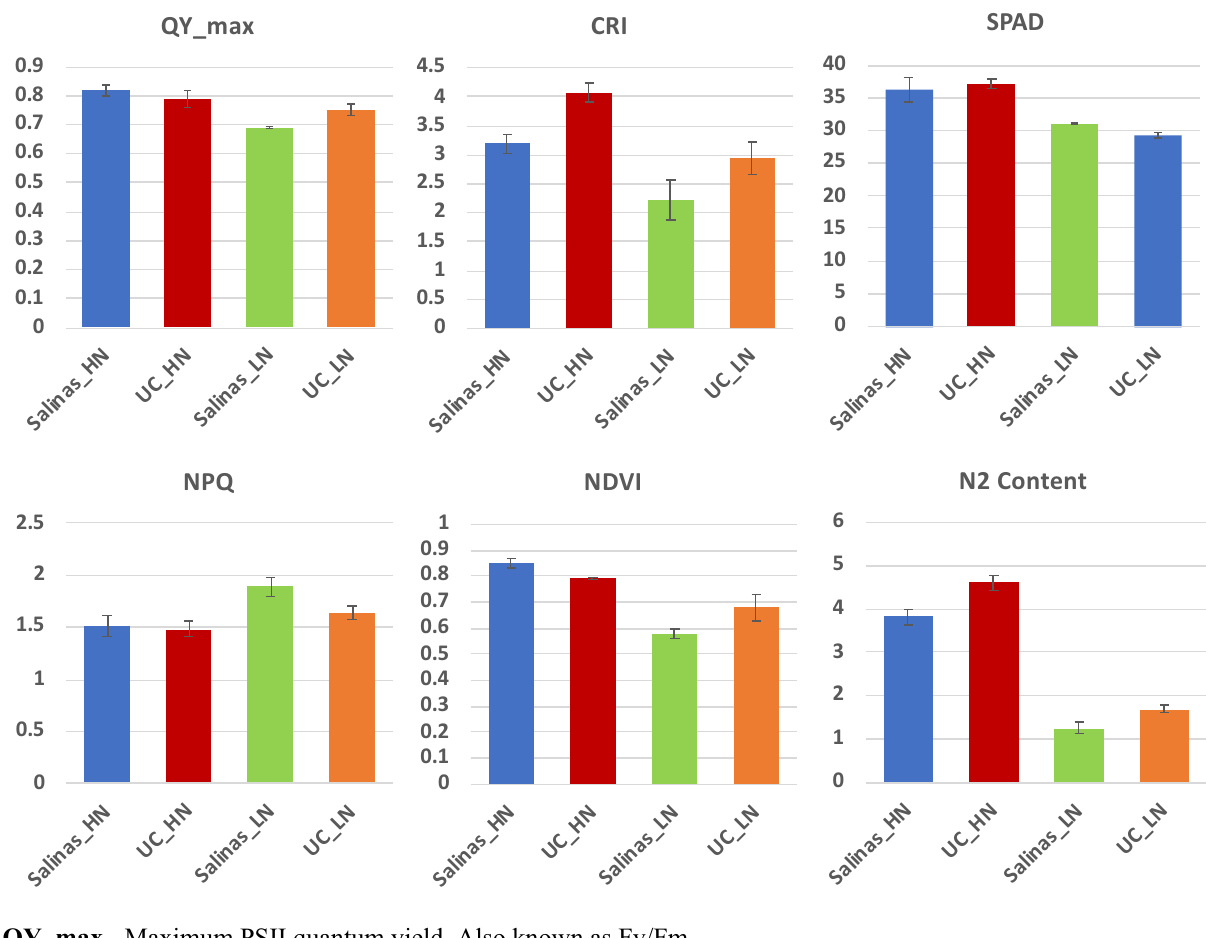
Figure 1. Phenotypic reaction of two lettuce genotypes to high nitrogen (HN) and low nitrogen (LN)